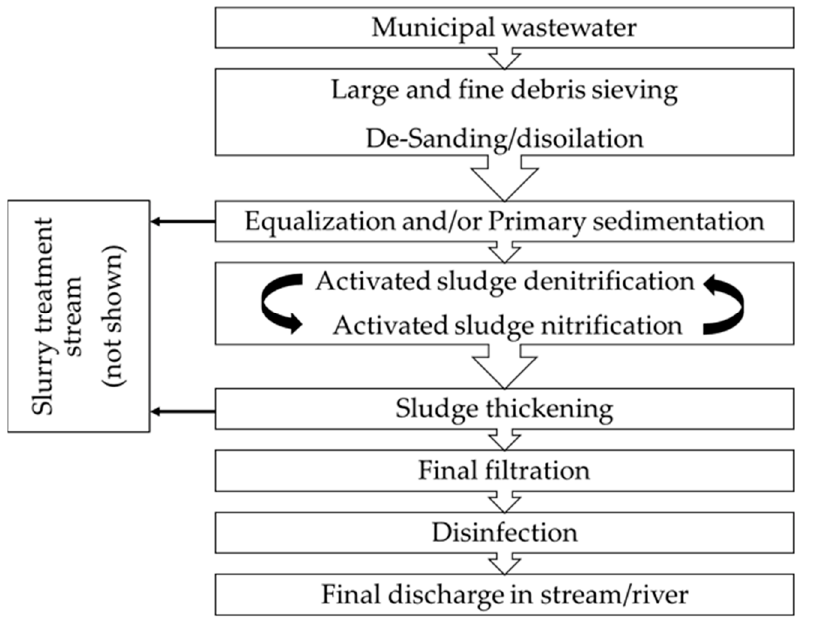
Figure 1. Basic scheme of water treatment in the plants. Only the water treatment stream is shown in detail.